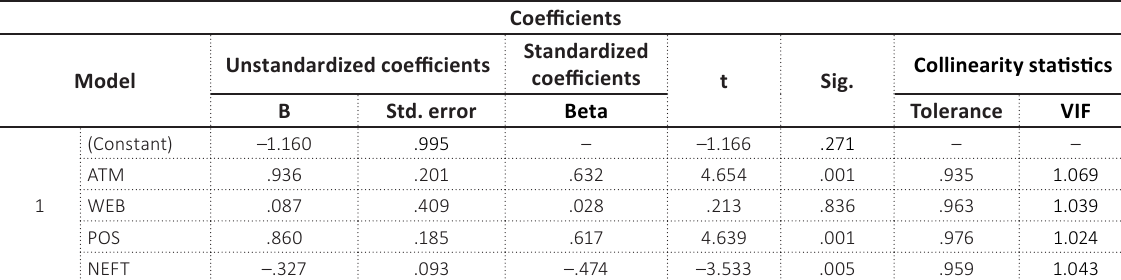
Table 3. Multicollinearity test